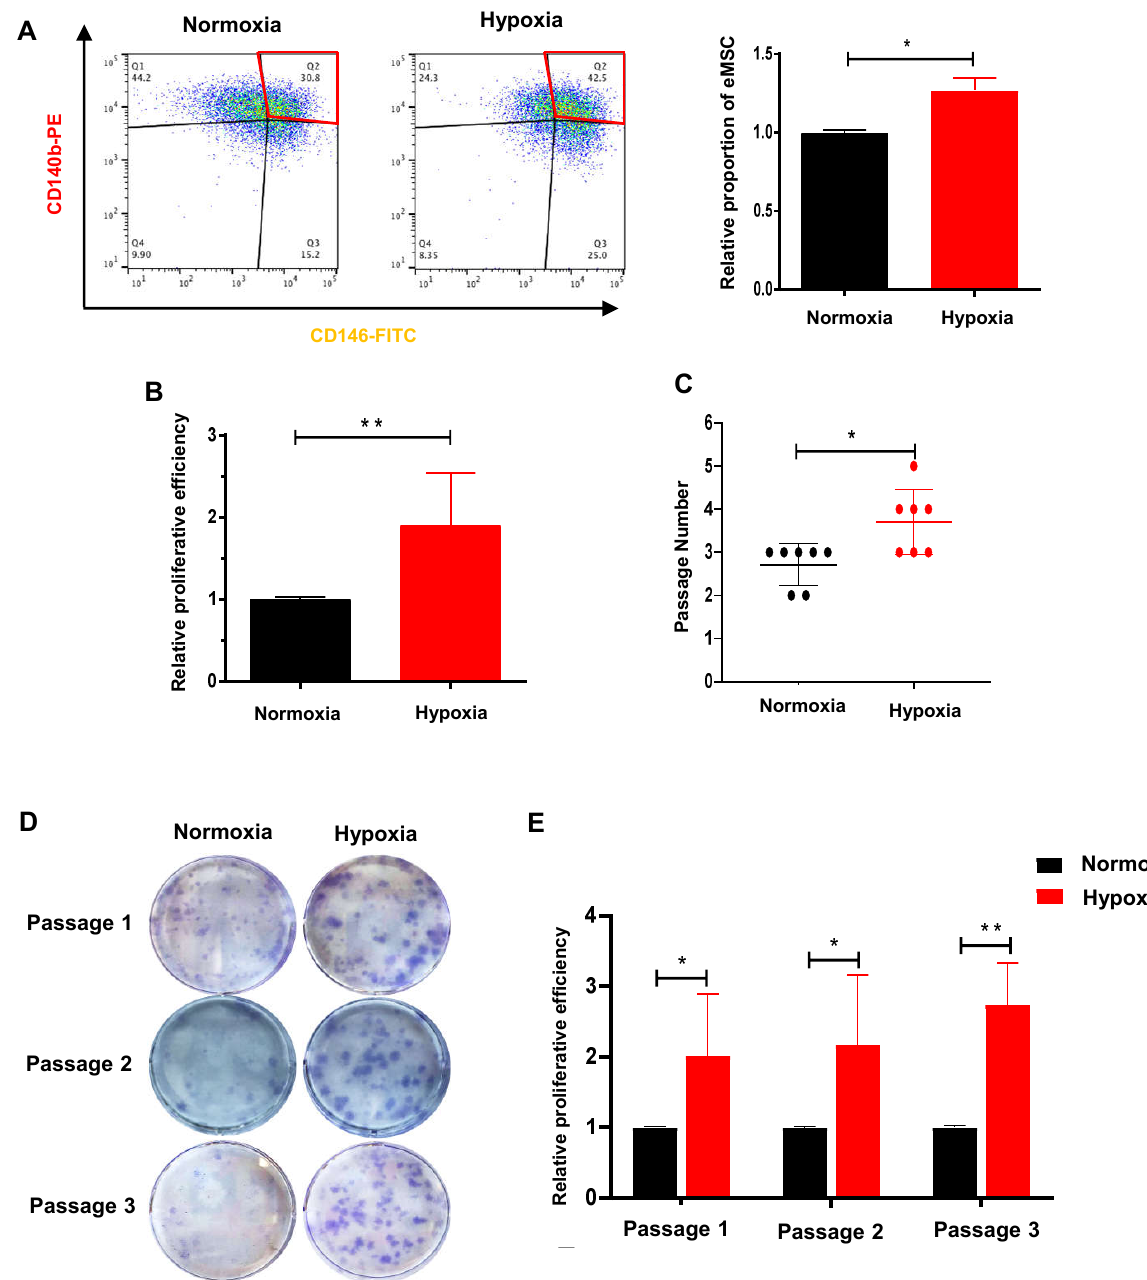
Figure 3. Hypoxia promotes eMSC proliferation and self-renewal. ( A ) Representative images and relative percentage of CD140b + CD146 + cells (red box) under normoxic (black bars) and hypoxic (red bars) conditions using flow cytometry ( n = 4). ( B ) Relative proliferative ability ( n = 6) and ( C ) self-renewal activity ( n = 7) of eMSC in normoxia and hypoxia. ( D ) Representative figures showing the total colony formation of eMSC cultured under normoxia and hypoxia at different passage ( n = 5–7). ( E ) Relative clonogenic efficiency of eMSC cultured under normoxia and hypoxia at different passage ( n = 5–7). Results are presented as mean ± SD; * p < 0.05; ** p < 0.01. Abbreviation: eMSC, endometrial mesenchymal stem-like cells.